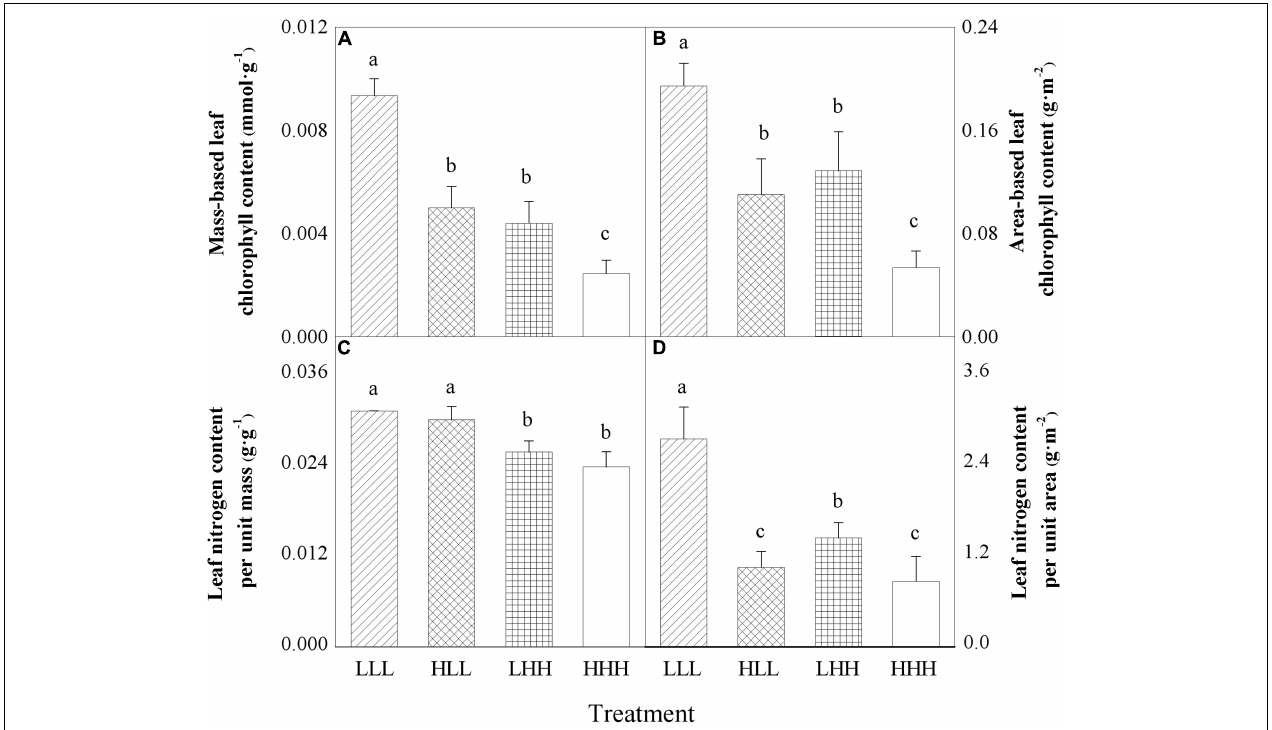
FIGURE 3 | Effects of transgenerational plasticity on leaf properties of offspring ramets (F 2 generation). The same lower case letters are not significantly different at the P = 0.05 level. Values are means ± s.e. (standard errors), n = 8. HHH: F 0 generation high light + F 1 generation high light + F 2 generation high light; HLL: F